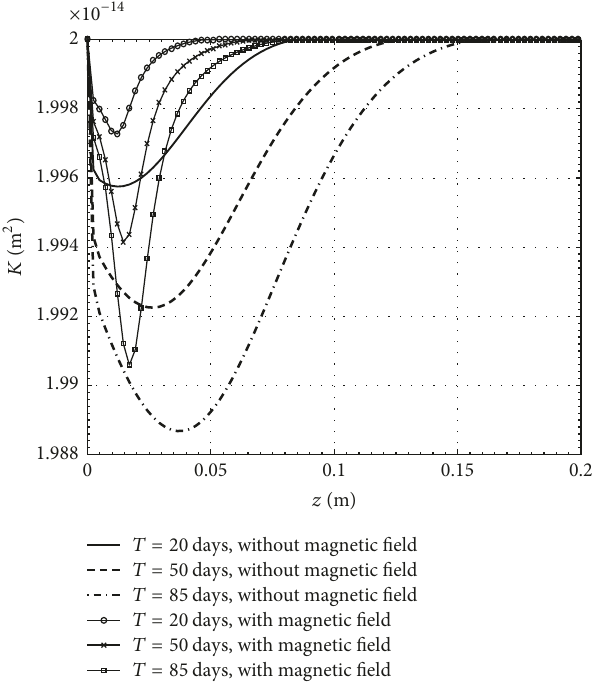
Figure 14: Permeability variation against core length with and without magnetic field effect for various values of imbibition time: magnet is placed on the left side of the core.